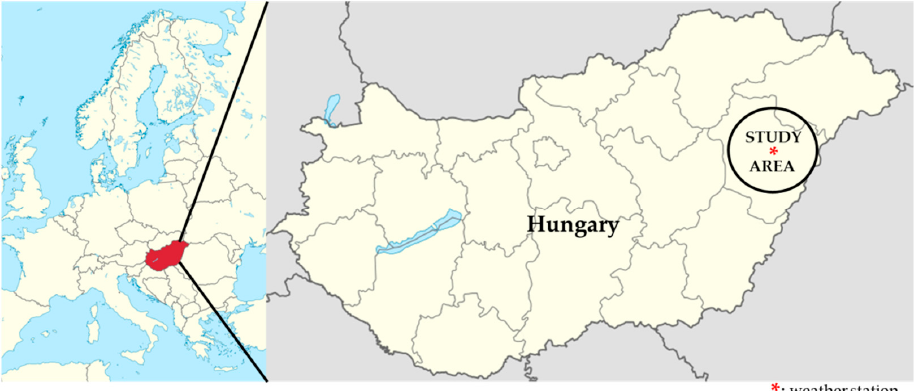
Figure 2. Study area in Hungary.